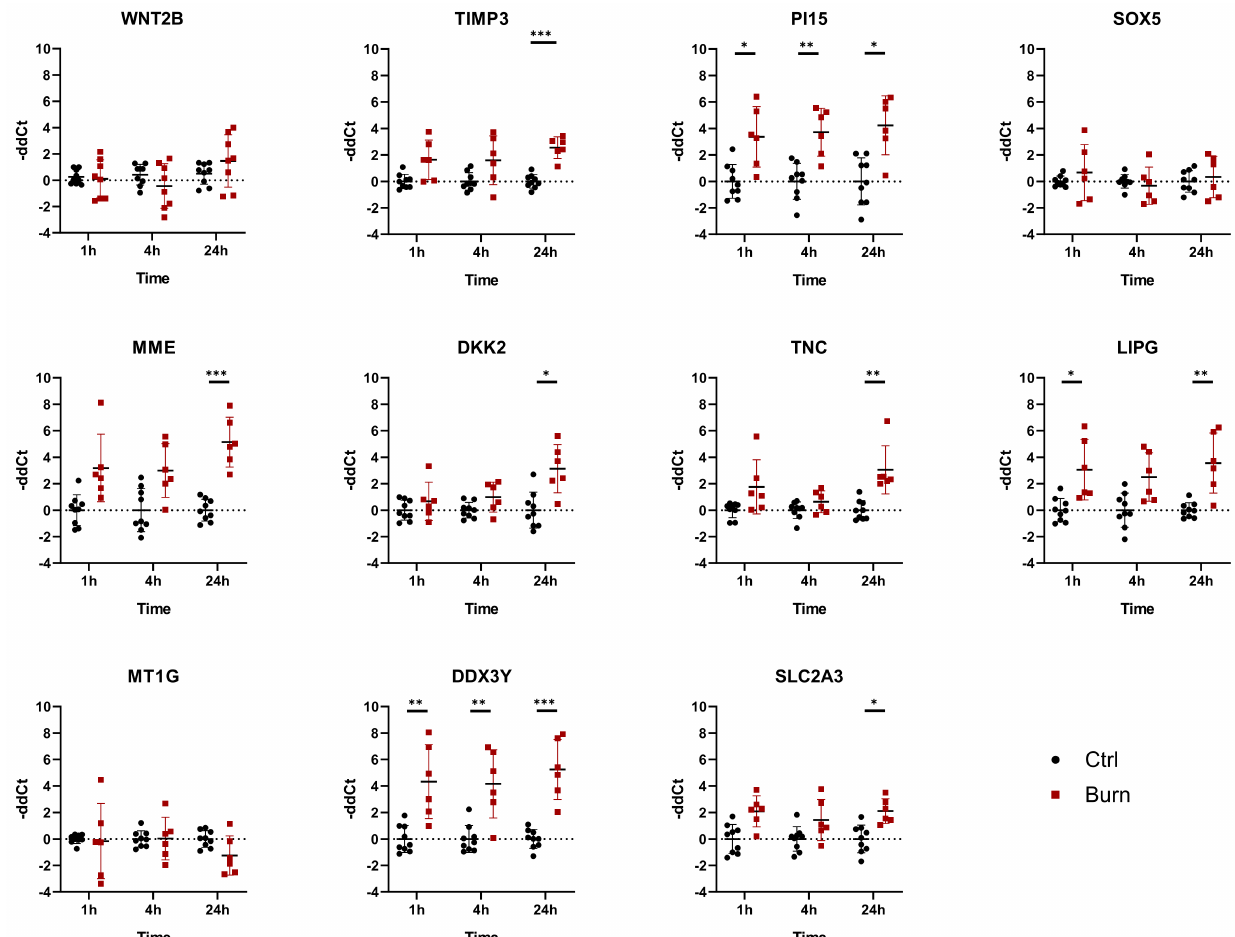
Figure 6. mRNA differential expression in biopsies from burned skin. Data are derived from 3 independent experiments and presented as individual values of –ddCt, normalized to TBP, RPLP0 and GAPDH and displayed relative to control samples, with means (line) and standard deviation (whiskers). Significance was tested with Student ´ s t -test, followed by Bonferroni correction; p -values < 0.05 were considered as statistically significant, with *, ** and *** indicating p < 0.05, p < 0.01 and p <